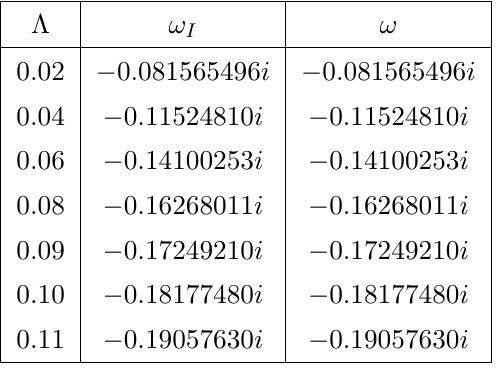
Table 2 . Dominant dS modes ( n dS = 0) for massless scalar (cid:12)elds with ‘ = 1 in the background of Schwarzchild-de Sitter black holes with M = 1. The values of ! I appear in ref.